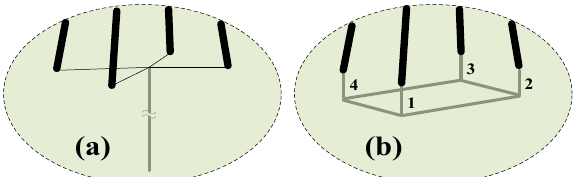
Figure 8: a) one-port 15m (and 3m) vertical rod, b) four- port 6mx6m square grid, used for tower-footing grounding systems of all towers.